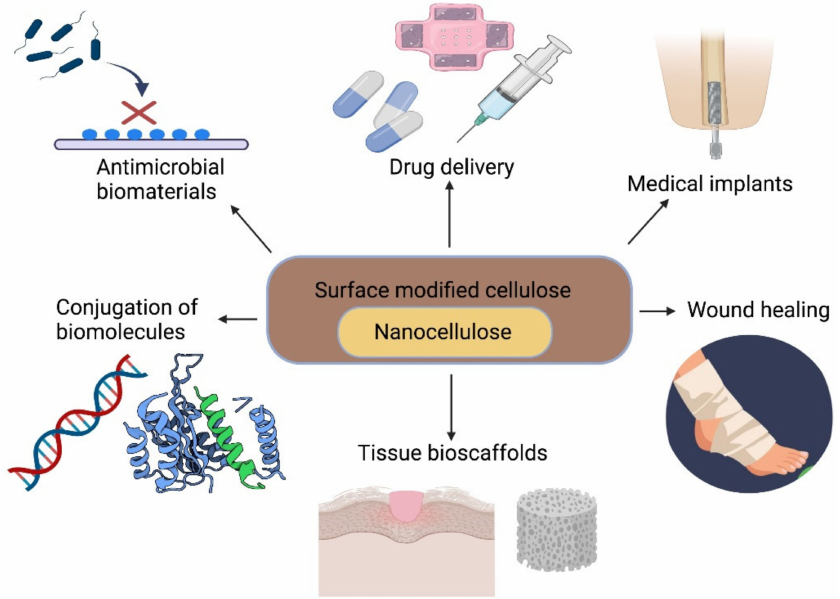
Figure 5. Examples of the uses of cellulose as a biomaterial (based on